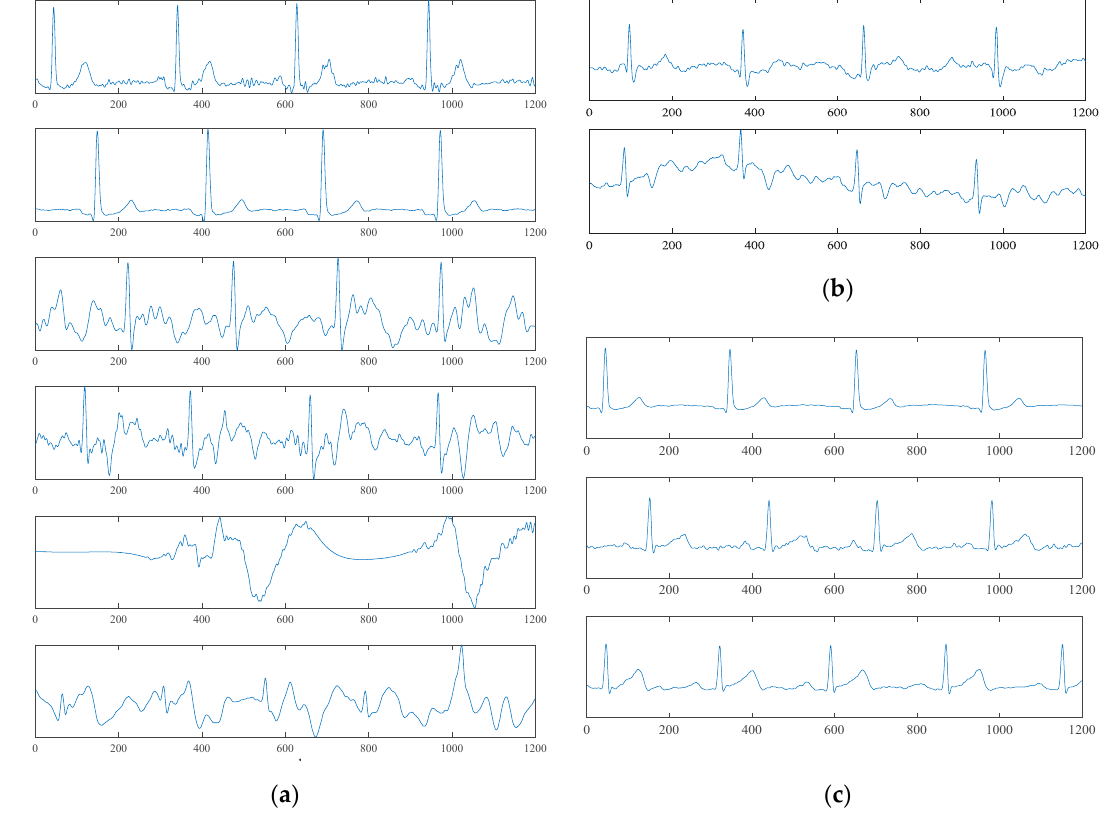
Figure 8. Exampling waveforms. ( a ) Exampling waveforms of 4 s time length correctly classified by the qua_model. The upper two subfigures belong to the C1 class, the middle two belong to the C2 class, and the lower two belong to the N class. ( b ) Misclassified samples of the C2 class. The upper sample was classified as C1; the lower sample was classified as N. ( c ) From top to bottom, the waveforms of the L, S, and R sleep